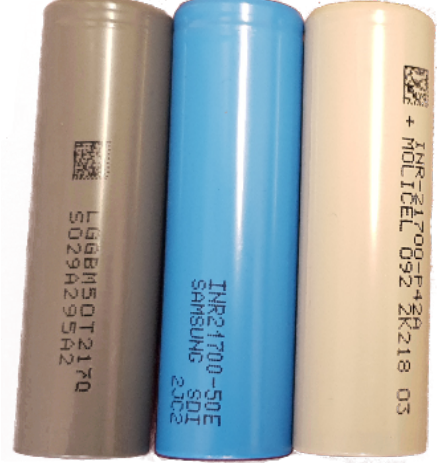
Figure 3. Cells used in this research, from left to right: LG M50T, Samsung 50E, and Molicel